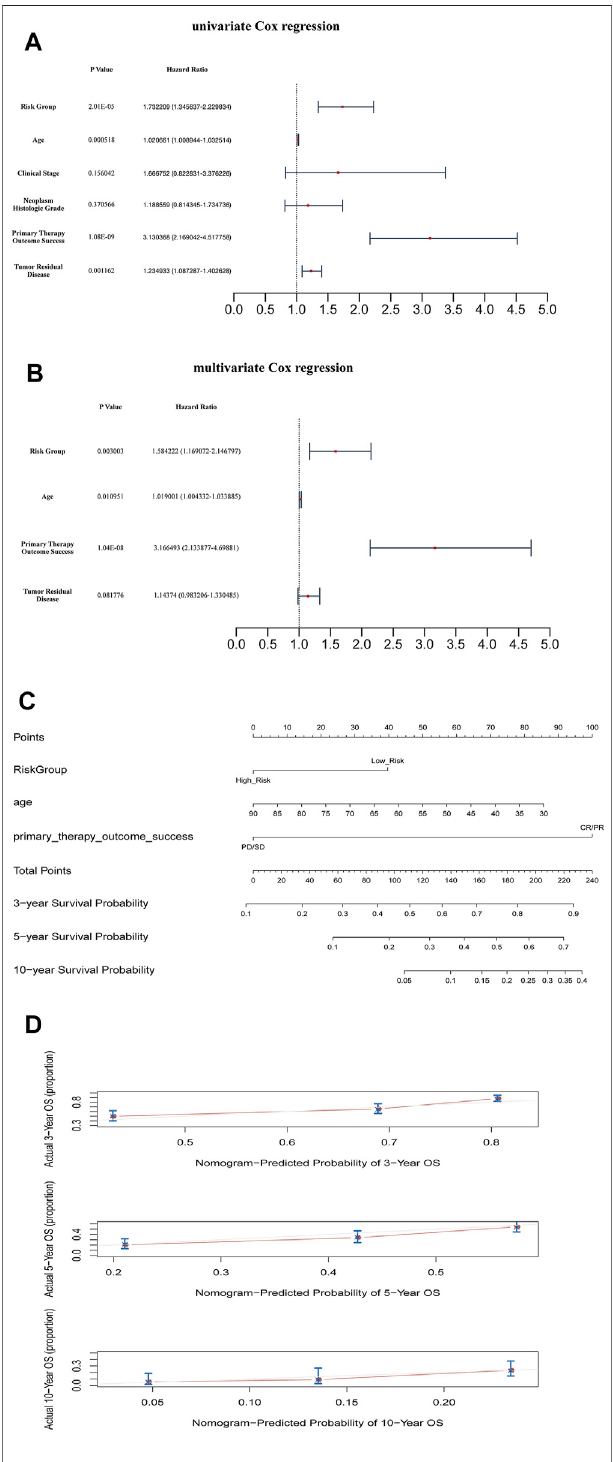
FIGURE 4 | Clinical value of risk score by independent prognostic analysis (A) The univariate Cox regression analysis (B) The Cox regression analysis (C) The Nomogram model based on risk model and clinical features (D) The calibration plots of the nomogram. The closer it was to 45 degrees or the gray lines in the graph, the better the fi tting